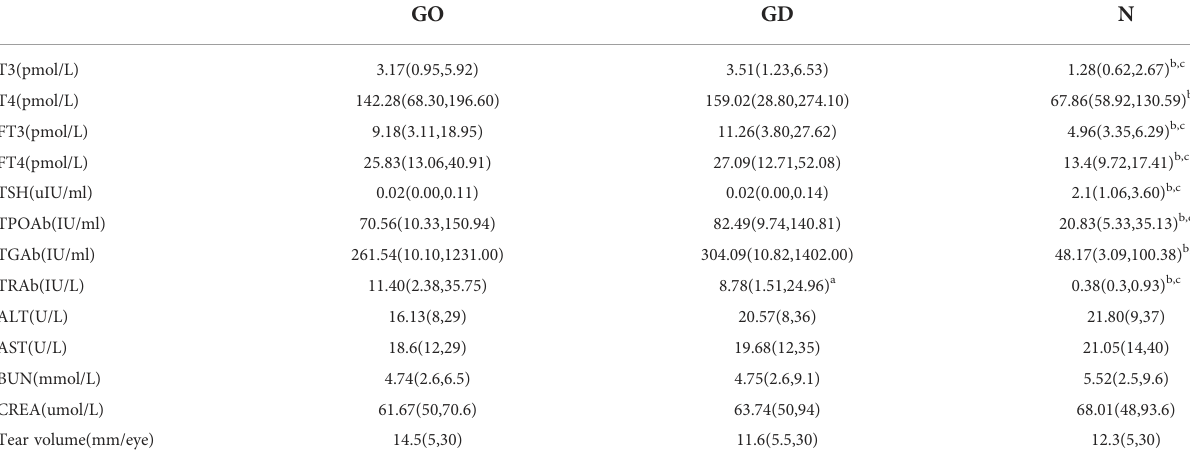
TABLE 2 Clinical data of patients with Graves ’ ophthalmopathy, patients with Graves ’ disease and healthy controls.